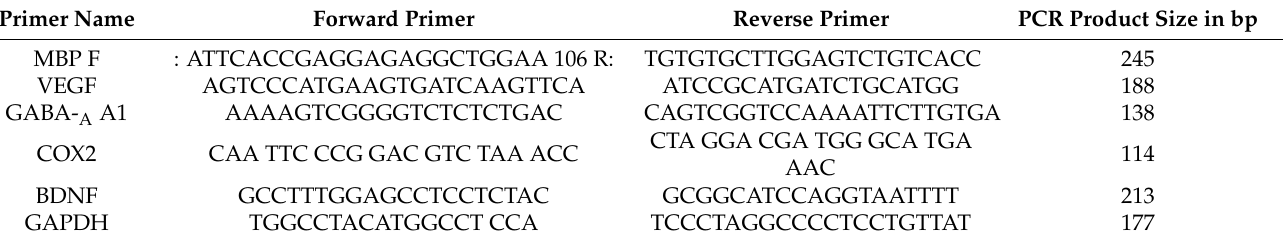
Table 1. Primer details of the mRNA target.